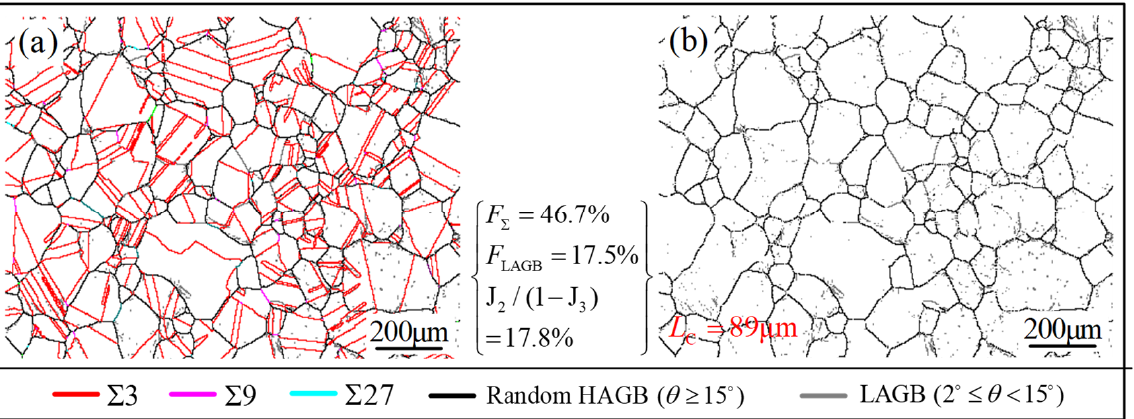
Figure 1. GB distribution map ( a ) and random GB map ( b ) of initial specimen (hot rolling at 800 °C with 5% reduction).